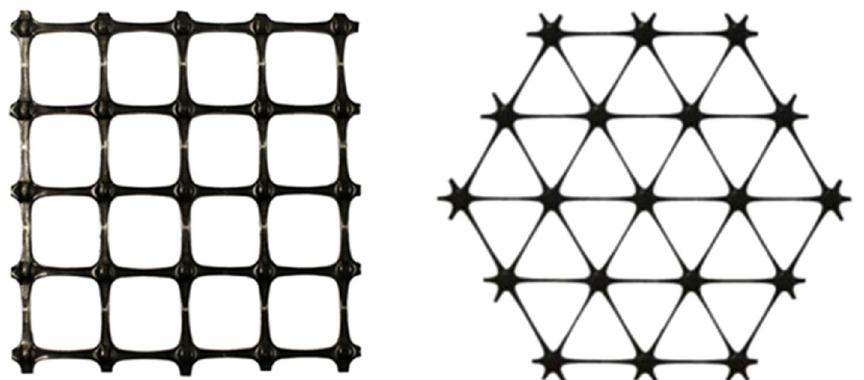
Figure 1. Biaxial and triaxial geogrid.